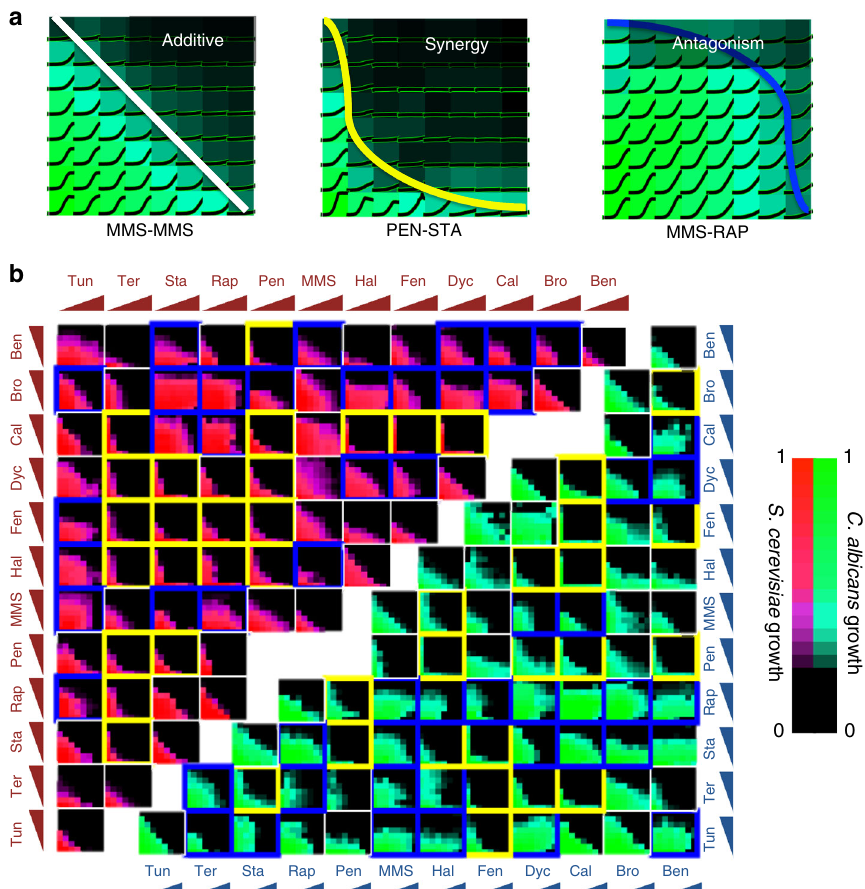
Fig. 1 Drug-interaction screen results in C. albicans and S. cerevisiae . a Classi fi cation of drug interactions. Yeast cells were grown in a 2D grid with linearly increasing concentrations of one drug on each axis. Representative experiments on C. albicans with growth curves are shown on a heat map for growth. Drug interactions are assessed based on the concavity of isophenotypic contours. On the left, a “ self – self ” experiment is shown, wherein MMS is increased on each axis. Such pairs are de fi ned as additive and have linear isophenotypic contours. Drug pairs with concave (PEN-STA) or convex (MMS-RAP) contours are de fi ned as synergistic or antagonistic, respectively. b Drug-interaction experiments among all pairwise combinations of 12 drugs in C. albicans and S. cerevisiae . Each subplot shows the growth level for each drug-concentration combination for C. albicans (green/teal) and S. cerevisiae (red/magenta). Synergistic or antagonistic drug pairs are shown in yellow or blue boxes, respectively. Eight S. cerevisiae experiments were newly conducted for this study: MMS tested against MMS, BRO, CAL, DYC, FEN, HAL, RAP, and TUN. Other experimental data involving S. cerevisiae were obtained from Cokol et al.,